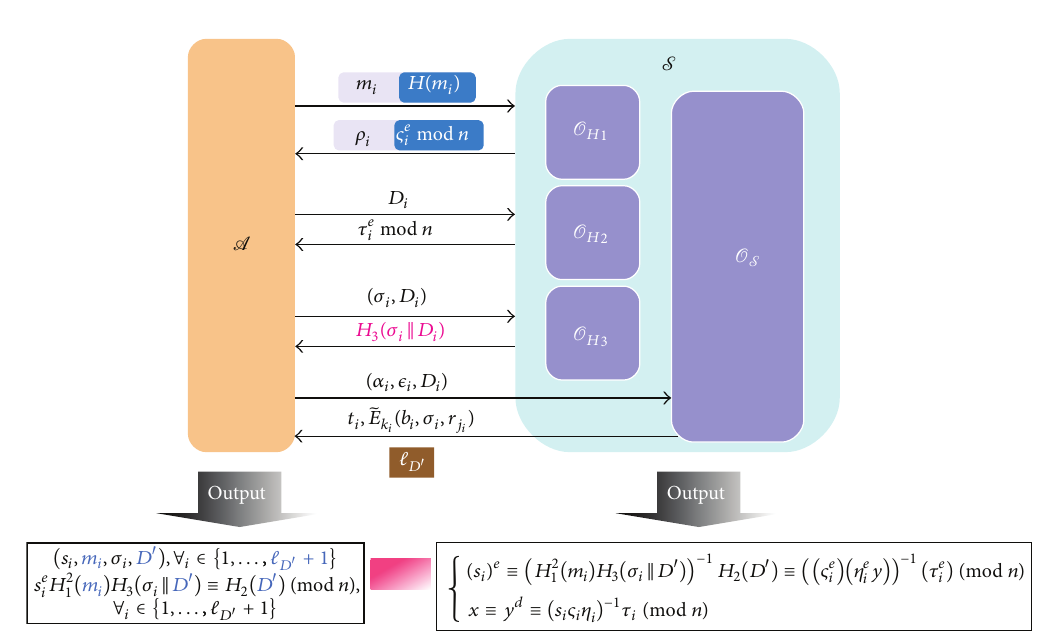
Figure 7: The proof model of